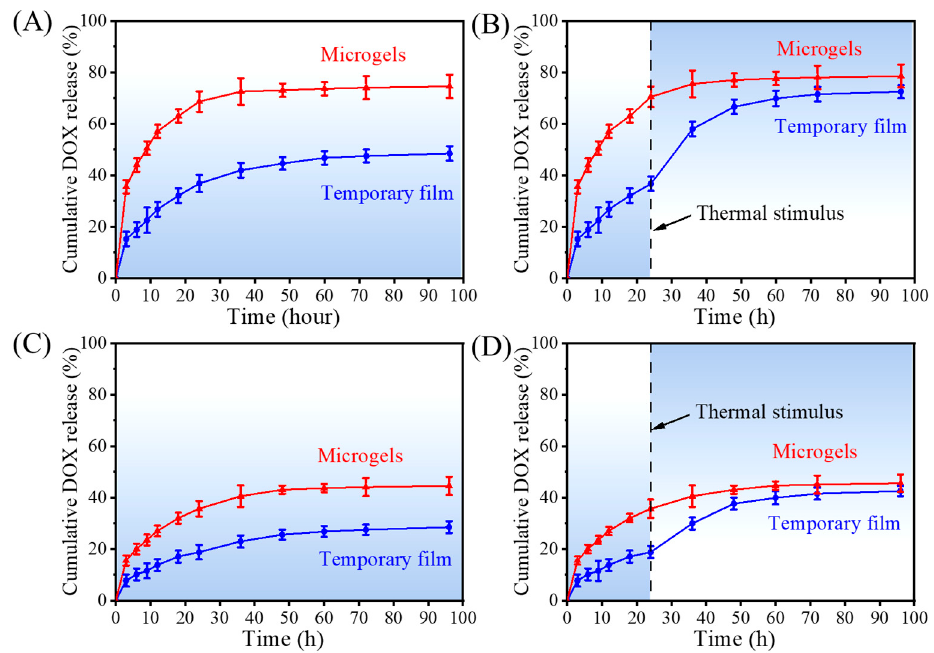
Figure 5. Drug-release profiles of DOX for the microgels and temporary film at pH = 5.6 ( A , B ) and at pH = 7.4 ( C , D ) without the thermal stimulus ( A , C ) and with the thermal stimulus for 10 min after the initial 24 h drug release ( B , D ).